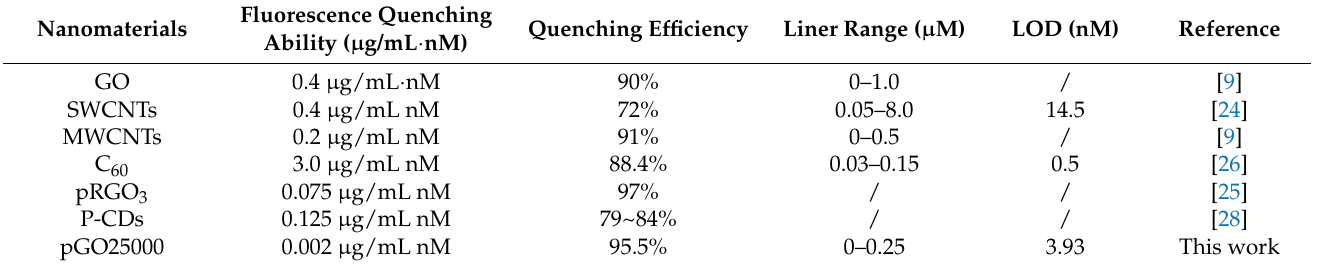
Table 1. Comparison of different nanomaterials as nanoquencher for Hg(II)